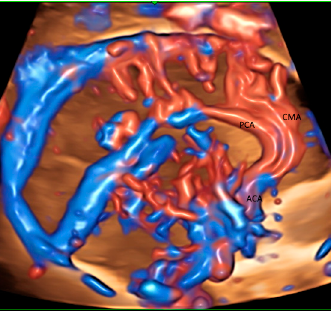
Figure 2. Glass-body rendering mode with high-definition Doppler showing the normal course of pericallosal artery (PCA) and its main branch, and callosomarginal artery (CMA) in a fetus with severe fetal growth restriction at 31 weeks’ gestation. ACA, anterior cerebral artery.